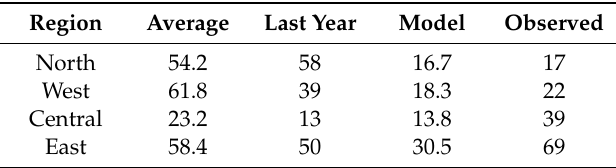
Table 14. Forecasts for the number of events with magnitude M ≥ 4 in 2017. The average number of these events in the period 2012–2016 is given, the number in 2016, the number predicted by the model and the observed number of events in